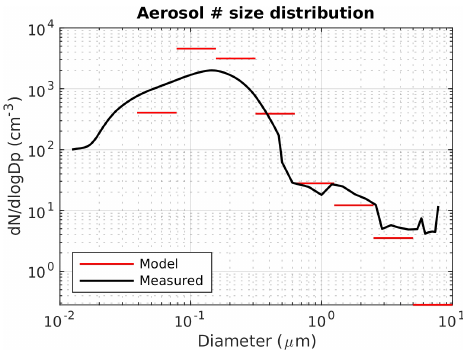
Figure 6. Comparison of model-simulated aerosol number concen- trations (cm − 3 ) corresponding to MOSAIC size bins compared to flight-measured values during the field campaign of August 2009. The widths of the red lines represent the widths of the eight MO- SAIC bins. The model data (eight bins) were extracted at the ex- act latitude, longitude, and altitude corresponding to the flight data by 3-D linear interpolation and averaged over the days available (11–30 August 2009) during the time of measurements ( ∼ 06:00 to